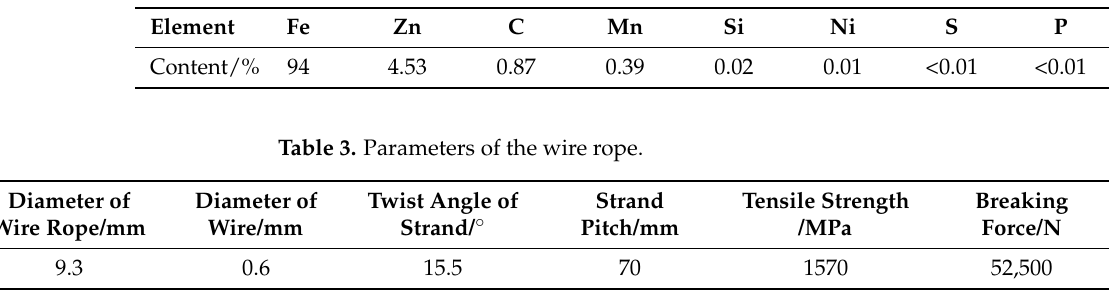
Figure 2. Wire rope sliding wear test rig. Table 2. Chemical element composition of the wire rope.